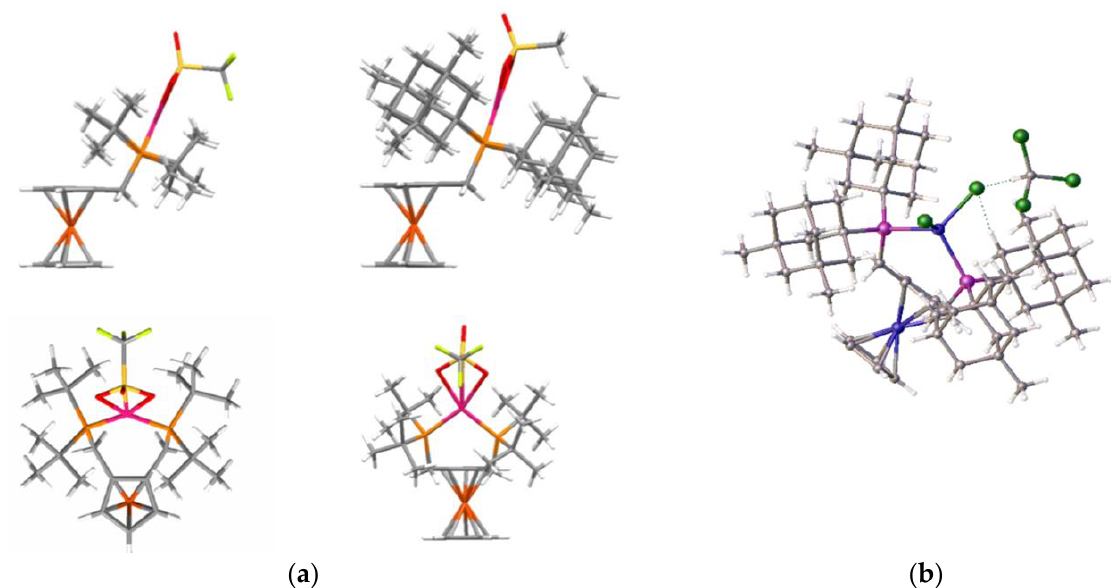
Figure 19. ( a ) Typical “above the plane” coordination of palladium (there is a methylsulphonate bound to the palladium); ( b ) NiCl 2 complex of ligand 2c . Figures supplied by I.R.Butler and P.N.Horton (data to be published).